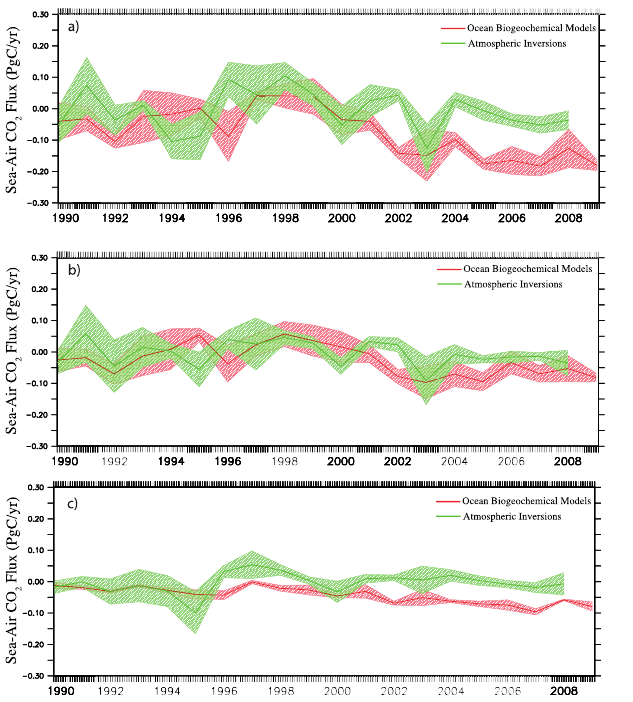
Fig. 9. The oceanic interannual variability in sea–air CO 2 flux from ocean biogeochemical and atmospheric inverse models in the period Figure 9 The oceanic interannual variability in sea-air CO 2 flux from ocean 1250 1990–2009. The upper panel represents the region 44–75 ◦ S, the biogeochemical and atmospheric inverse models in the period 1990-2009. The upper 1251 middle figure is the region 44–58 ◦ S and the lower region 58–75 ◦ S. panel represents the region 44 ° S-75 ° S, the middle figure is the region 44 ° S-58 ° S and 1252 The shaded area represents the sea–air CO 2 flux uncertainty associ- the lower region 58 ° S-75 ° S. The shaded area represents the sea-flux CO 2 flux 1253 ated with each approach. Negative values reflect flux into the ocean. uncertainty associated with each approach. Negative values reflect flux into the ocean. 1254